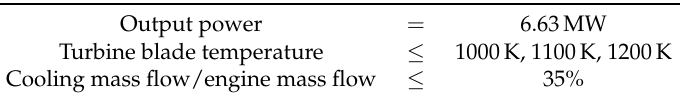
Table 3. Constraints for